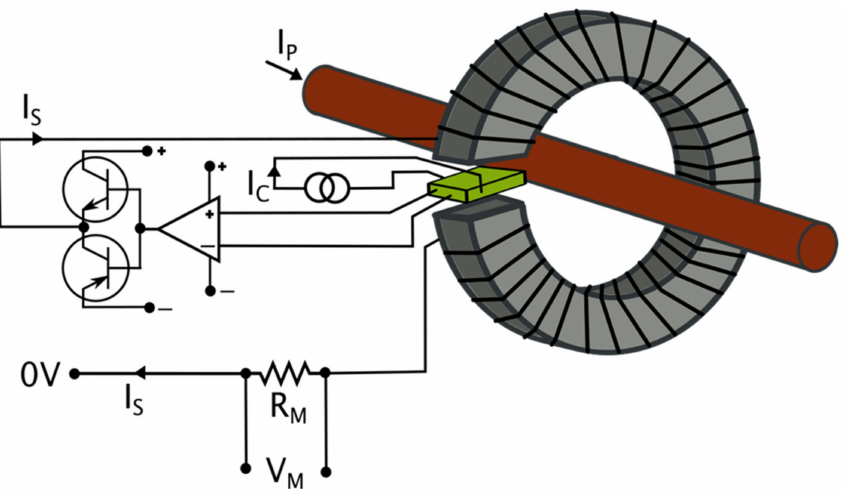
Figure 2. Principle of operation of the closed-loop